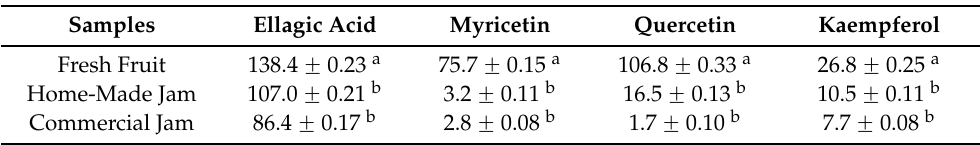
Table 1. Content (expressed as µ g/g fresh weight ˘ standard deviation) of ellagic acid, myricetin, quercetin and kaempferol in strawberry fresh fruits and strawberry